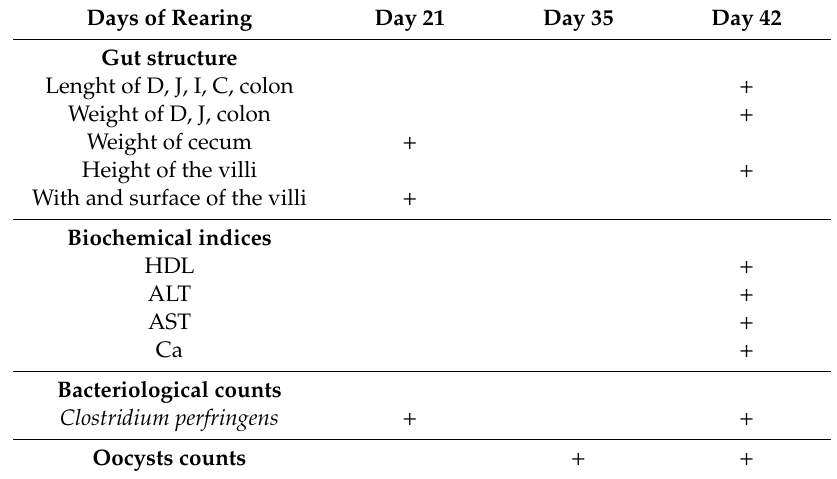
Table 4. The beneficial e ff ects related to physiological health observed in the chickens after a single in ovo injection with RFO